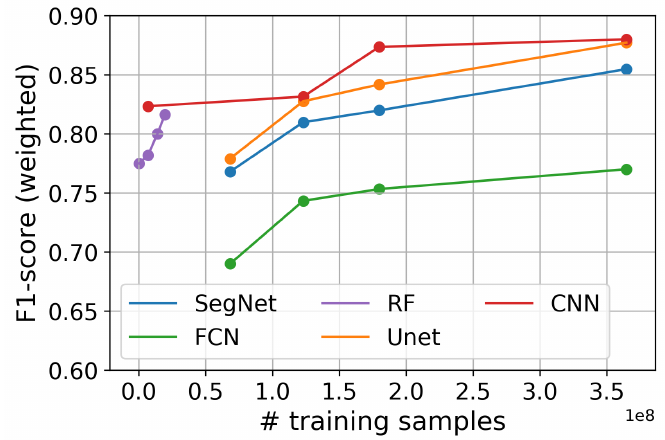
Figure 4. Effect of the training-set size on the weighted